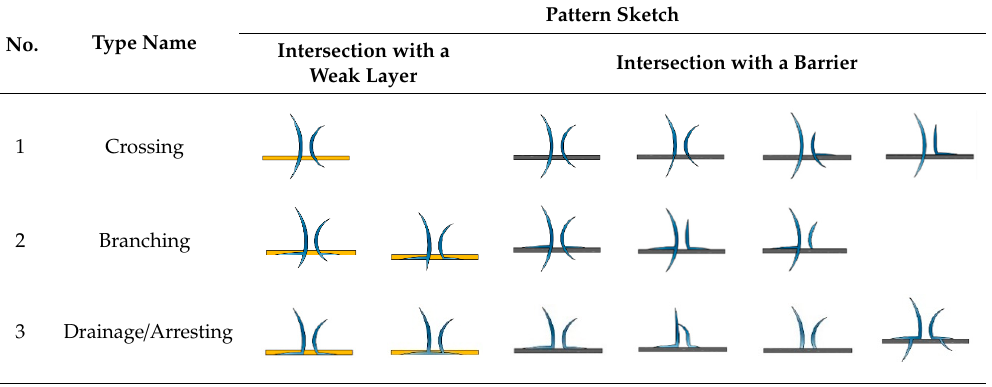
Table 6. Possible scenarios upon the intersection between dual fractures and the interlayer. No.